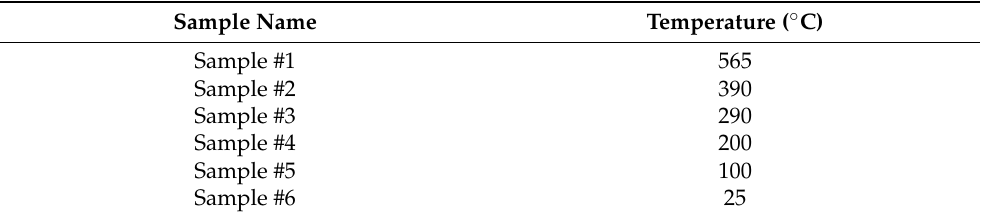
Table 2. Temperatures at which the analysed samples were